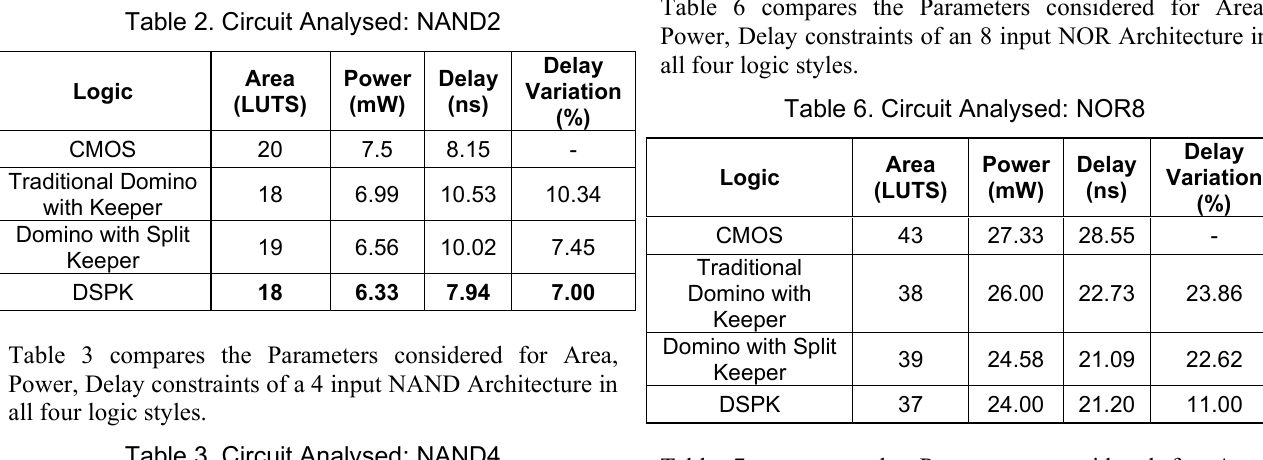
Table 3. Circuit Analysed: NAND4